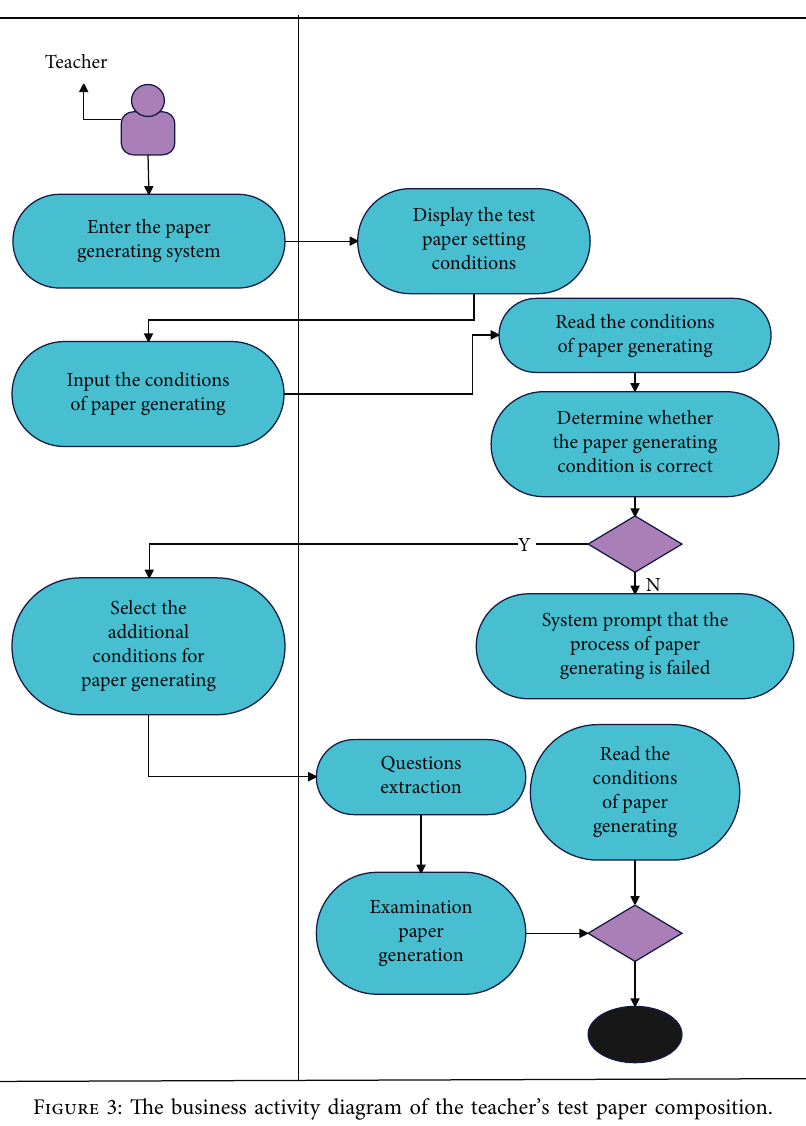
Figure 3: The business activity diagram of the teacher’s test paper composition.